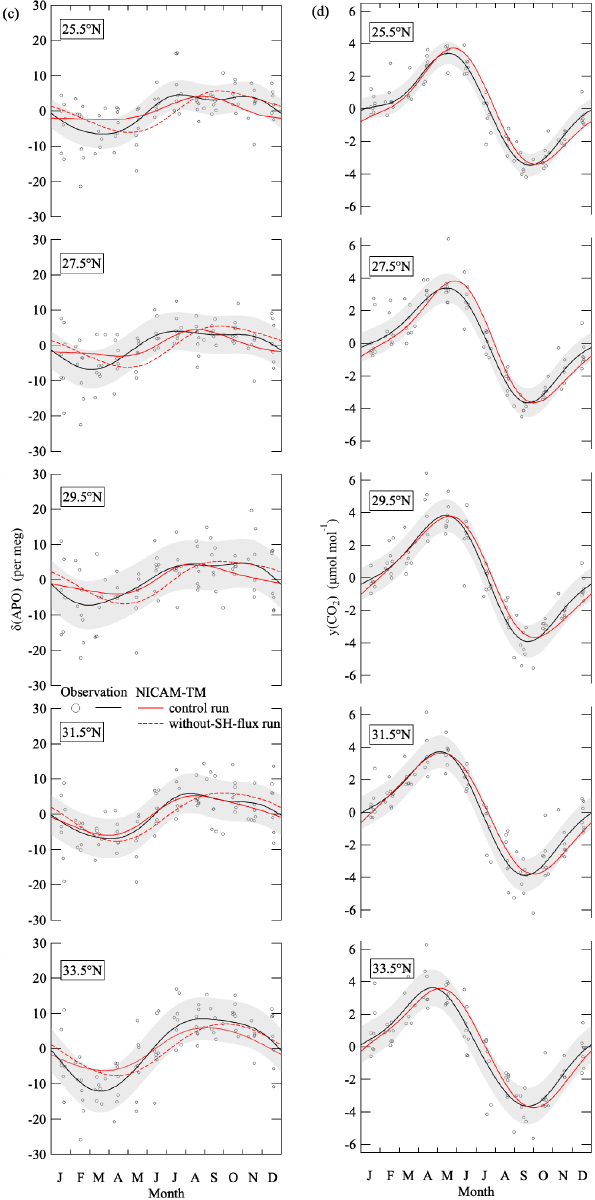
Figure 6. (a) Average seasonal cycles of δ (APO) and the CO 2 amount fraction observed in the troposphere at various latitudes over the western North Pacific. Dashed lines denote the average values throughout the observation period. (b) Same as in (a) but for calculated values obtained from the NICAM-TM control run and the corresponding results from the without-SH-flux run (see text). (c) Same average seasonal cycles of the observed and simulated δ (APO) in (a) and (b) , along with the detrended observed values at each latitude. Error bands (shaded) indicate standard deviations of the observed δ (APO) from the average seasonal cycles ( ± 1 σ ). (d) Same as in (c) but for the CO 2 amount